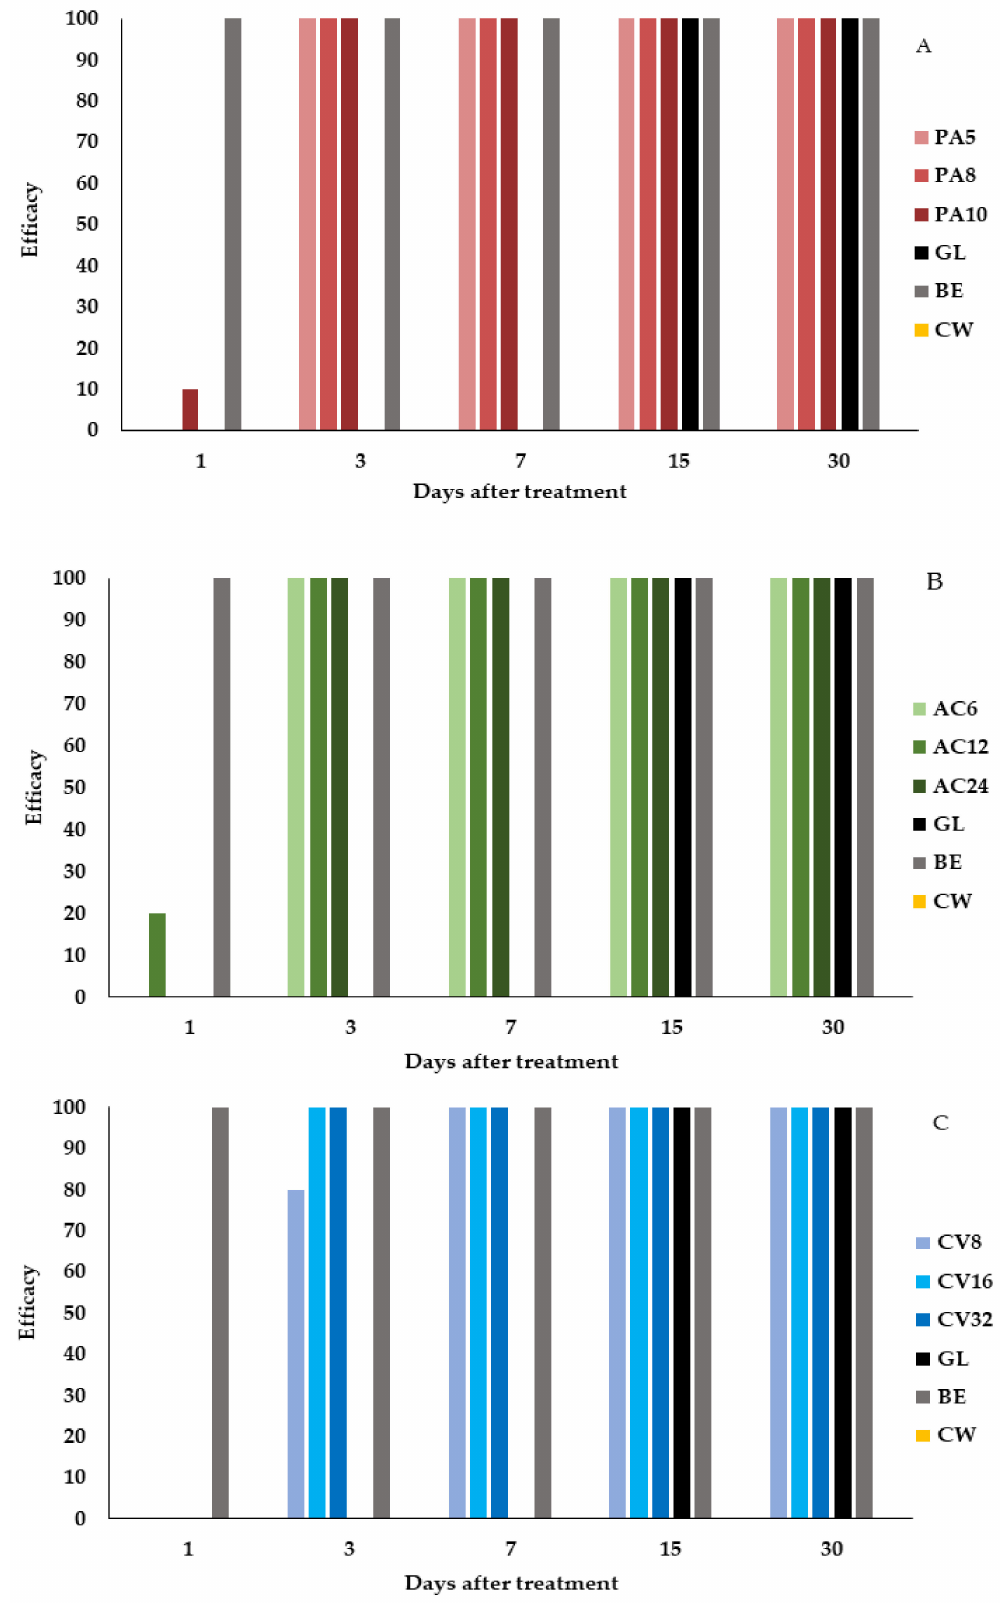
Figure 5. Evolution of e ffi cacy of the tested treatments ( A ) pelargonic acid, ( B ) cinnamic aldehyde, and ( C ) carvacrol in A. fatua during 30 days after their